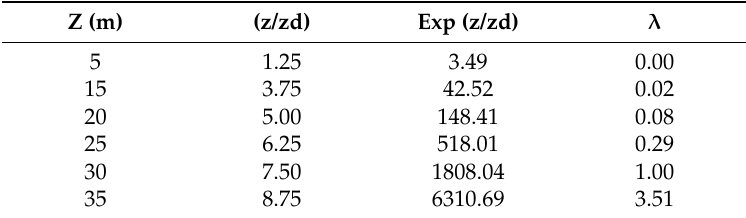
Table 3. Relationship between z and λ (zd = 4 m, ta = 1800 s).